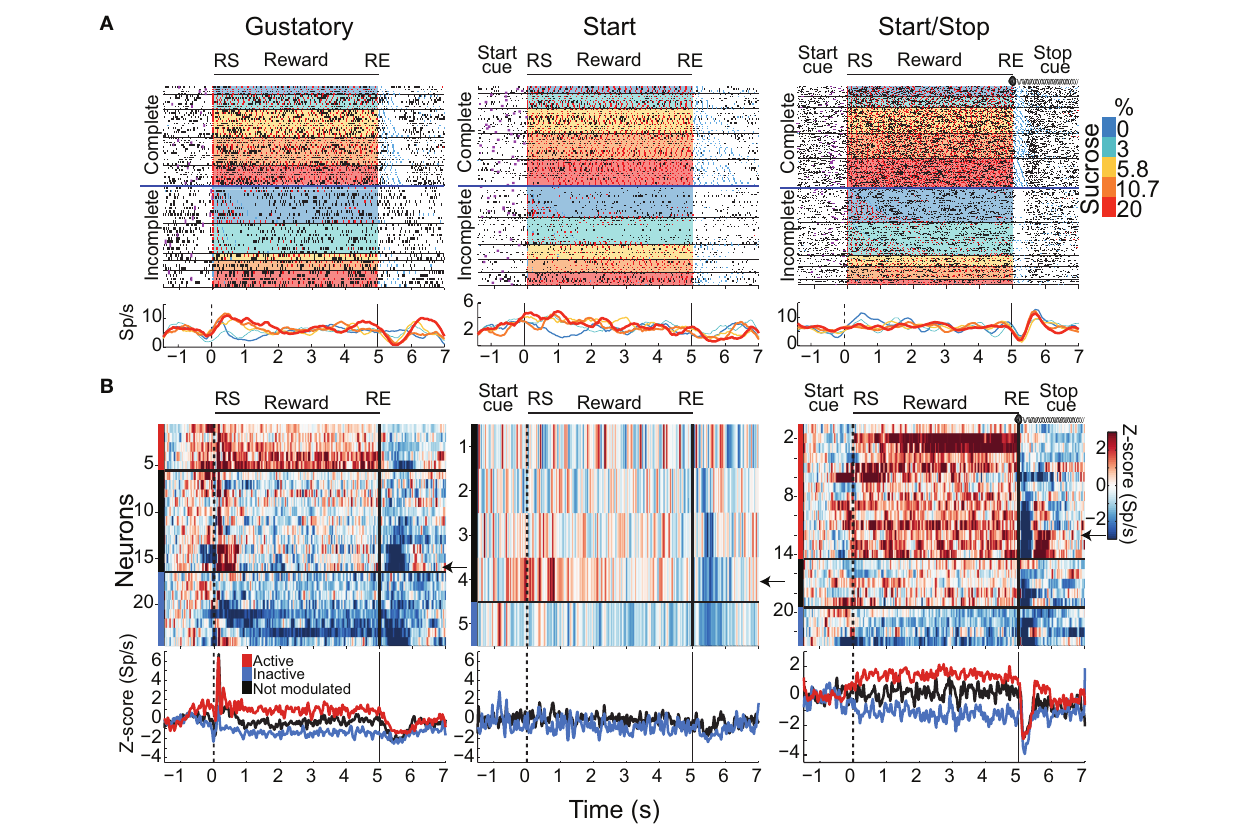
FIGURE 9 | A population of NAcSh neurons signals the Reward End (RE) by transiently inhibiting their activity after the first available cue signal that the Reward epoch has ended. (A) Raster plots of representative neuronal responses aligned to the RS of neurons recorded in the Gustatory (left), the Start (middle), and Start/Stop (right) tests that, after the reward end (RE), display a transient inhibition. Note that in both Complete and Incomplete trials (separated by a horizontal blue line) the inhibitions in the Start/Stop task were more phase-locked to the RE. (B) The color-coded normalized Z-scores, using a baseline − 1.5 to 0.5s relative to and aligned with RS of all neurons with a phasic inhibition after RE and their corresponding population PSTH below ( n = 24, 5, and 23 for Gustatory, Start, and Start/Stop test, respectively). Neurons were characterized as a function of their modulation profile relative to licking: Lick-Active, Lick-Inactive, and Not modulated. Black horizontal lines in the upper panel separate the three groups. On the left side, the vertical bars in color indicate their membership to each subgroup with the same conventions as in Figure 6 . The arrow indicates the example shown in rater plot in (A)